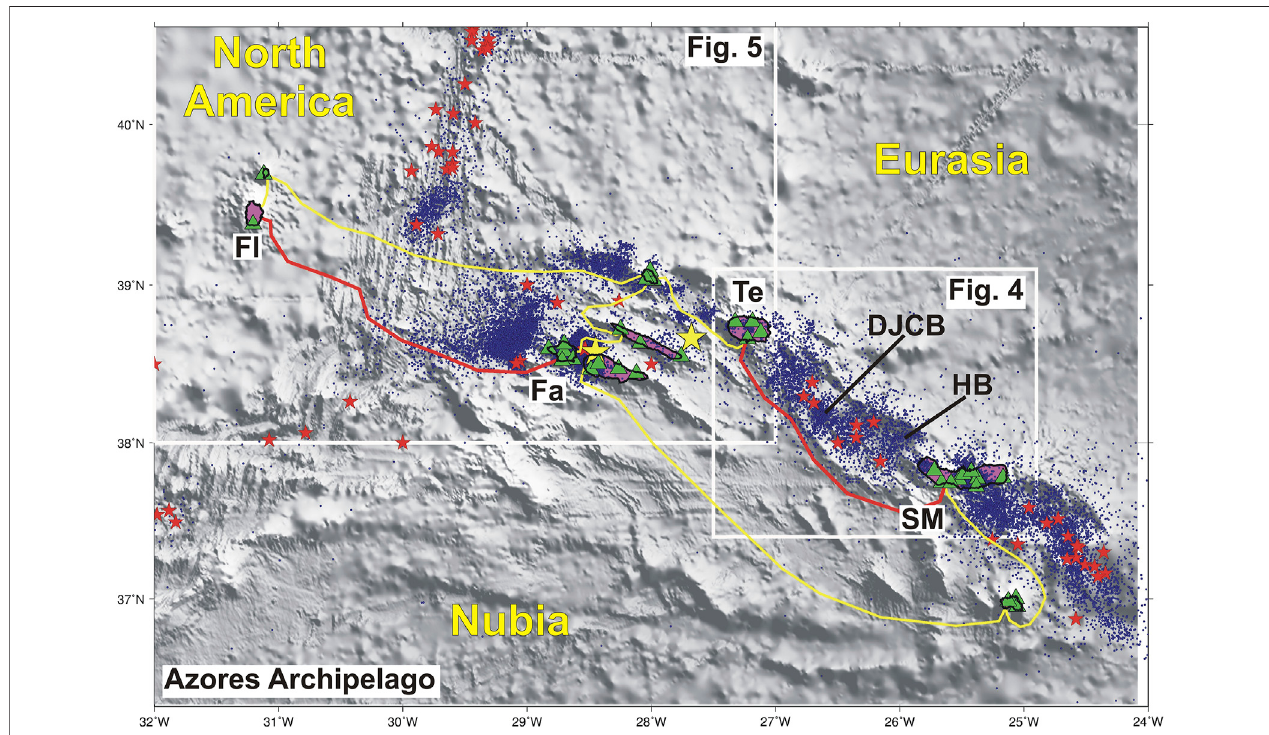
FIGURE 2 | Sketch location of the submarine telecom cables in operation at the Azores archipelago (yellow and red lines) overlaying the shaded bathymetry map (Smith and Sandwell, 1997). Frame location provided on fi gure 1. The cables in red will be discussed in detail later in the text. White boxes for Figures 4 , 5 . Green triangles show the location of the land seismic stations used by IPMA for earthquake monitoring. Small blue dots: epicenters from ISC, 1960 – 2019, http://www.ISC.ac. uk. Red starts show the epicenters for M > 5 from ISC, 1920 – 2019. The large yellow stars show the location of the two most recent destructive earthquakes, the January 1, 1980 and July 9, 1998. Islands mentioned in the text, Fl – Flores, Fa – Faial, Te – Terceira, SM – S. Miguel. DJCB – D. João de Castro Bank, HB – Hirondelle